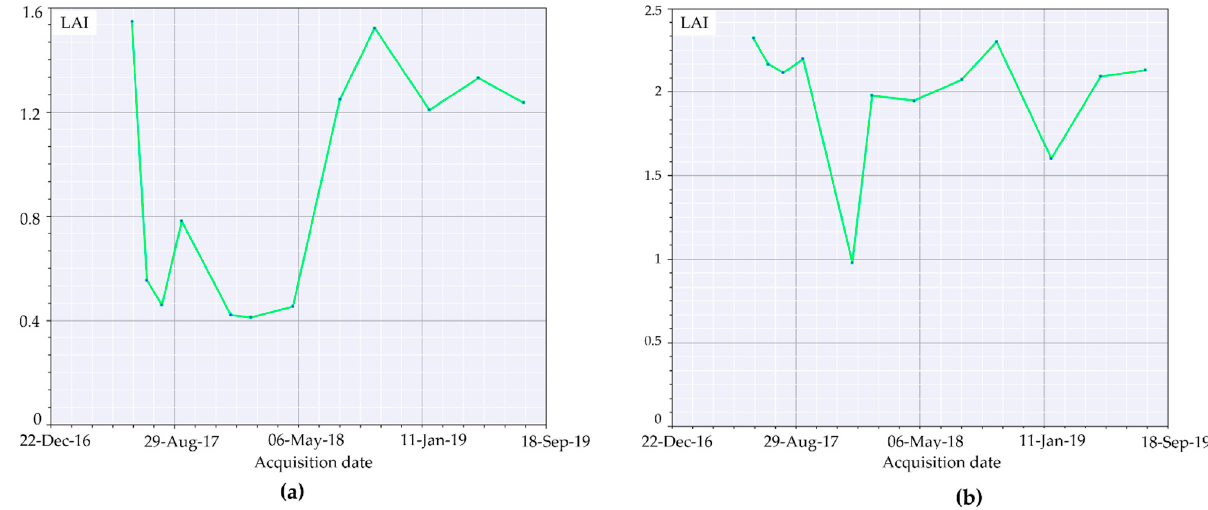
Figure 8. LAI index timeseries computed for: ( a ) the burned area (medium severity); ( b ) unburned area.